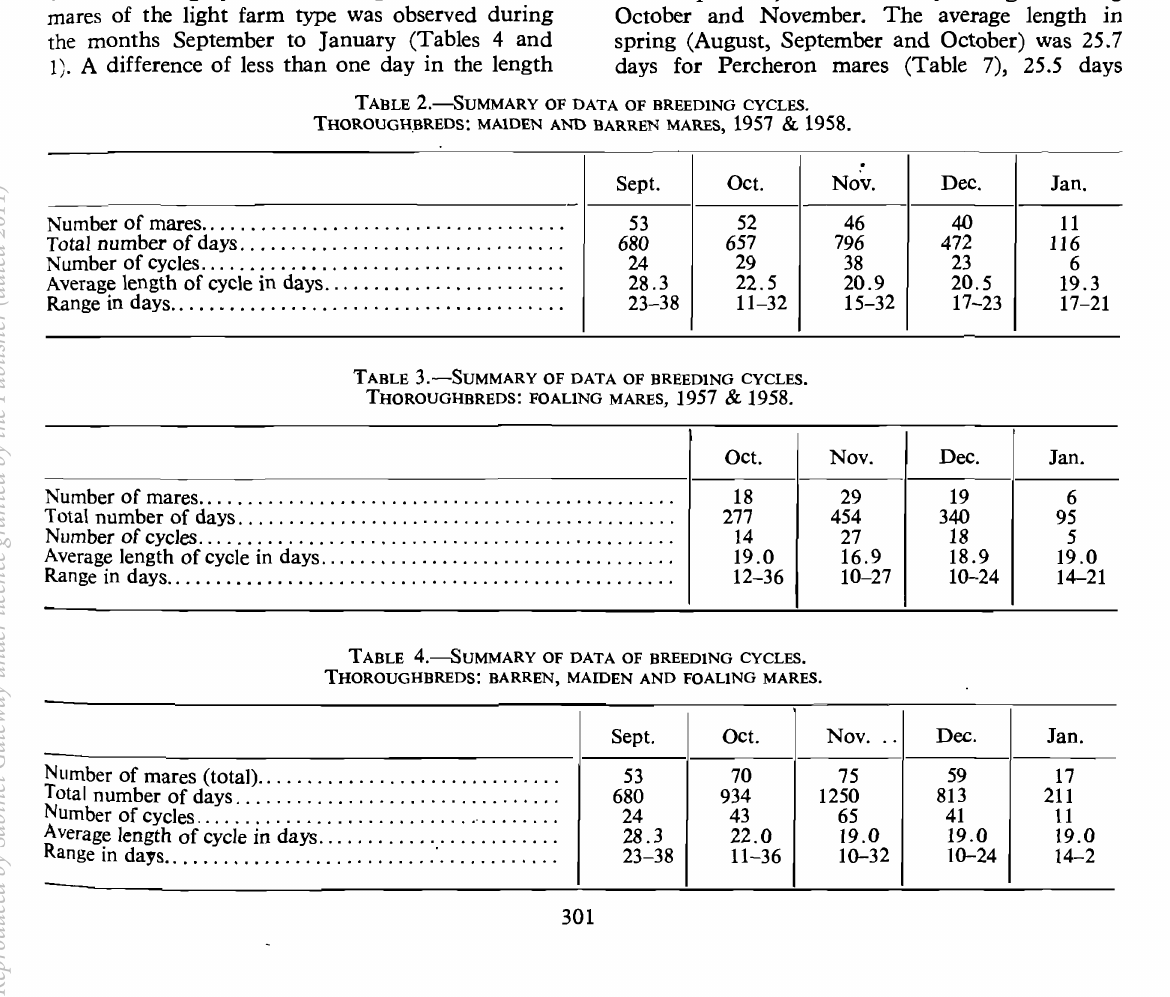
TABLE 2.-SUMMARY OF DATA OF BREEDING CYCLES. THOROUGHBREDS: MAlDEN AND BARREN MARES, 1957 & 1958. Sept.